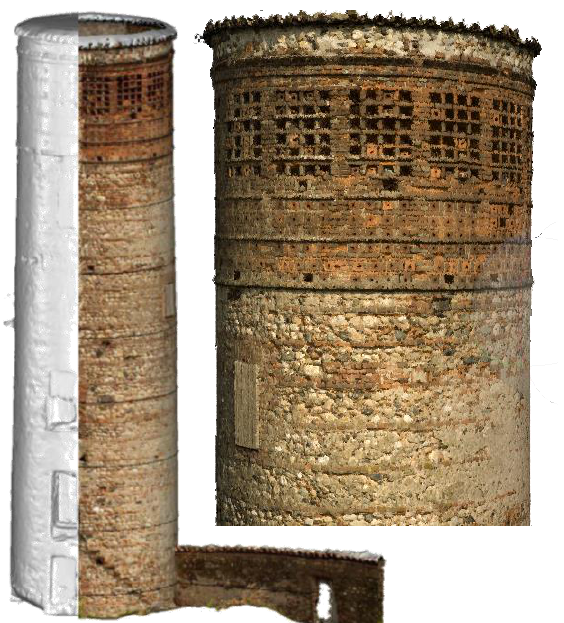
Figure 5. The 3D photogrammetric model and a zoomed image on the dense point cloud on the dovecot